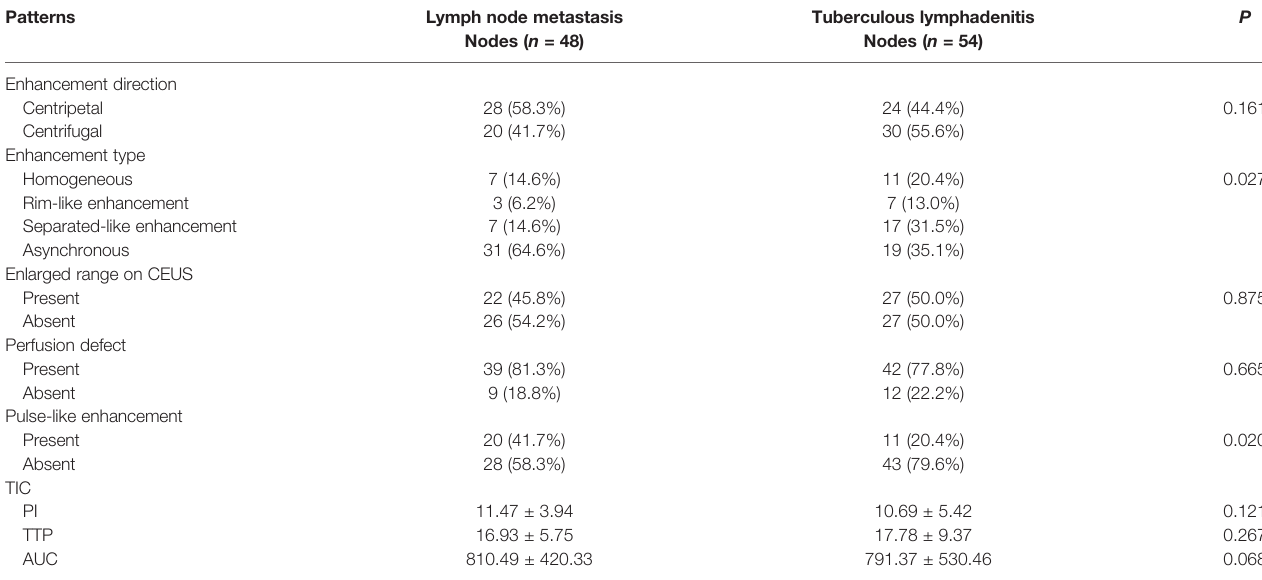
TABLE 2 | CEUS and TIC characteristics of tuberculous lymphadenitis and lymph node metastasis. Patterns